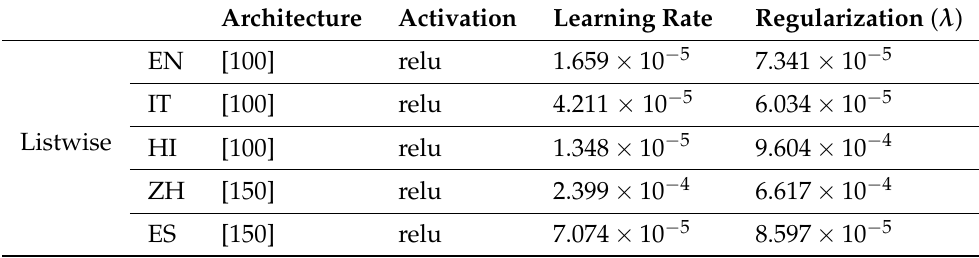
Table 5. The best hyperparameters for each methodology and corpus found by our search